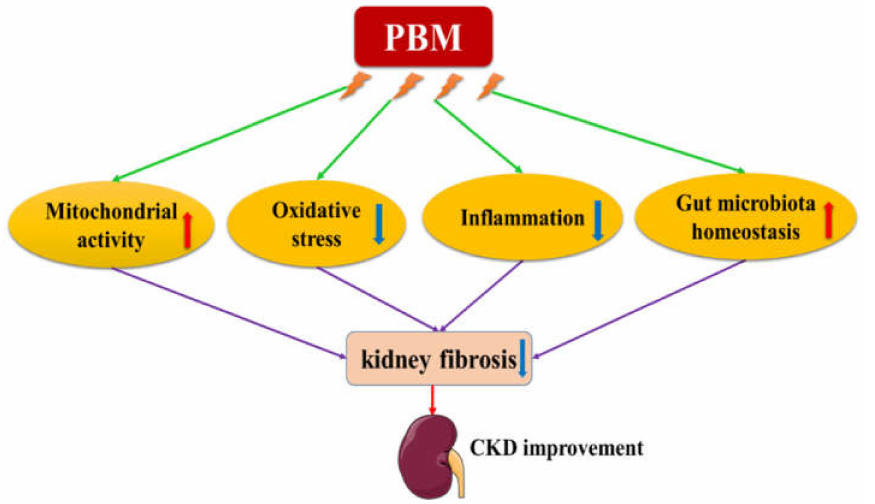
Figure 1. Potential mechanisms of the therapeutic effects of PBM on CKD. PBM may improve kidney function by promoting mitochondrial activity, suppressing oxidative stress, inhibiting inflammation, and restoring gut microbiota